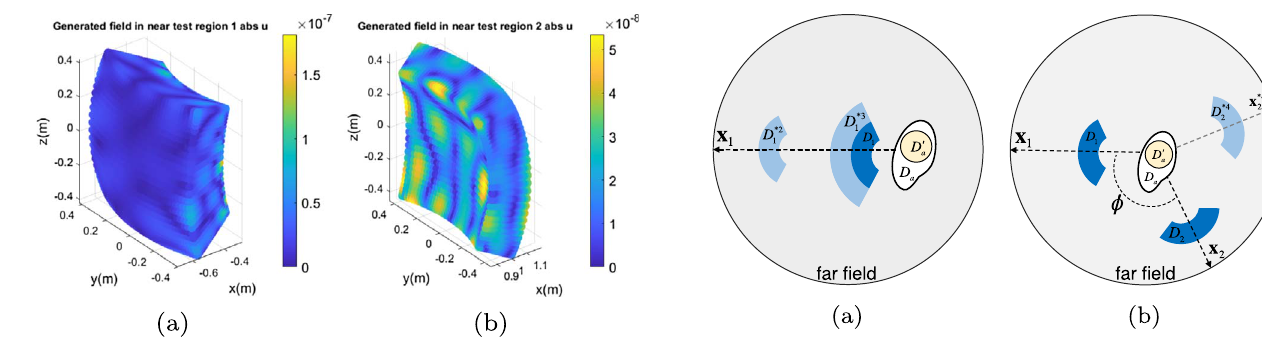
Figure 6. Pointwise magnitudes of the generated fi elds on (a) D 1 and (b) D 2 , both approximating a null fi